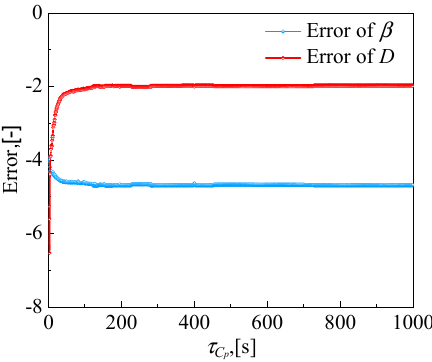
Figure 9. Errors of β and D with different τ Cp (Bi = 1).